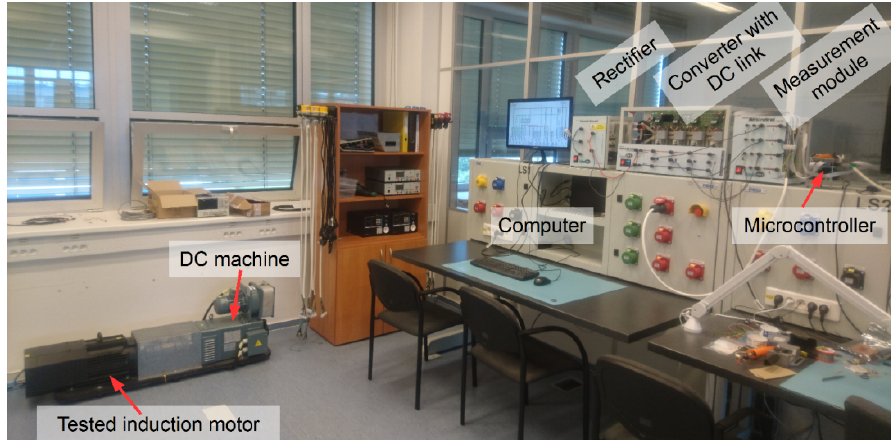
Figure 4. Picture of the test bench.